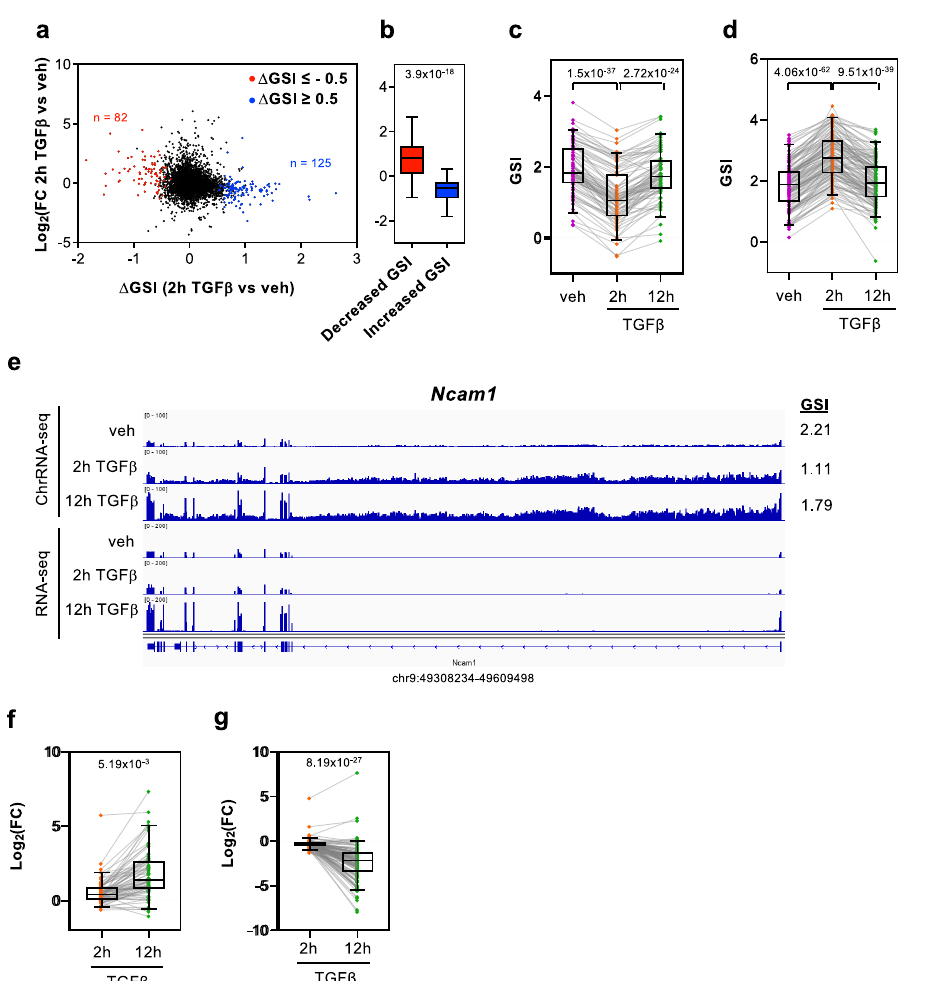
Fig. 4 Change of GSI ( Δ GSI) after 2 h of TGF β treatment. a Scatter plot of nascent pre-mRNA level changes (log 2 FC) versus GSI changes ( Δ GSI) after 2 h of TGF β treatment. Genes with decreased GSI ( Δ GSI < – 0.5, p < 0.05) or increased GSI ( Δ GSI > 0.5, p < 0.05) are depicted in red or blue, respectively. b Boxplot of nascent pre-mRNA level changes (log 2 FC) after 2 h of TGF β treatment versus vehicle, for genes with decreased or increased GSI values. Unpaired Student ’ s t -test p -values are shown. c , d GSI levels at the three conditions tested (vehicle, 2 and 12 h of TGF β treatment) for genes with decreased GSI ( c ) or increased GSI ( d ) after 2 h of TGF β treatment. e ChrRNA-seq and RNA-seq IGV snapshot of Ncam1 gene as example of a transient change of GSI after 2 h of TGF β . f , g Changes of mature mRNAs level (log 2 FC) after 2 h or 12 h of TGF β of genes with decreased ( f ) or increased GSI ( g ) at the 2 h TGF β time point. c , d , f , g Paired Student ’ s t -test p -values of the comparison between the indicated distributions are shown. Sample size ( n ) of all set of data are provided in Supplementary Data